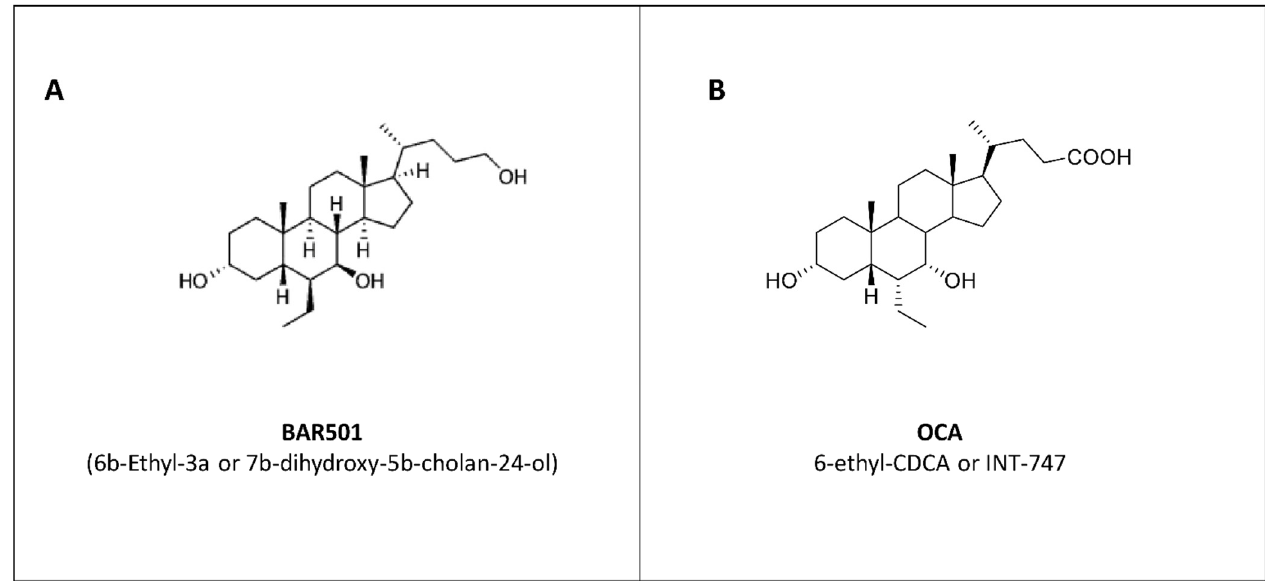
Figure 3. Chemical structures. Chemical structures of synthetic derivatives of BAs: ( A ) BAR501, selective agonist of GPBAR1, and ( B ) OCA, selective agonist of FXR.